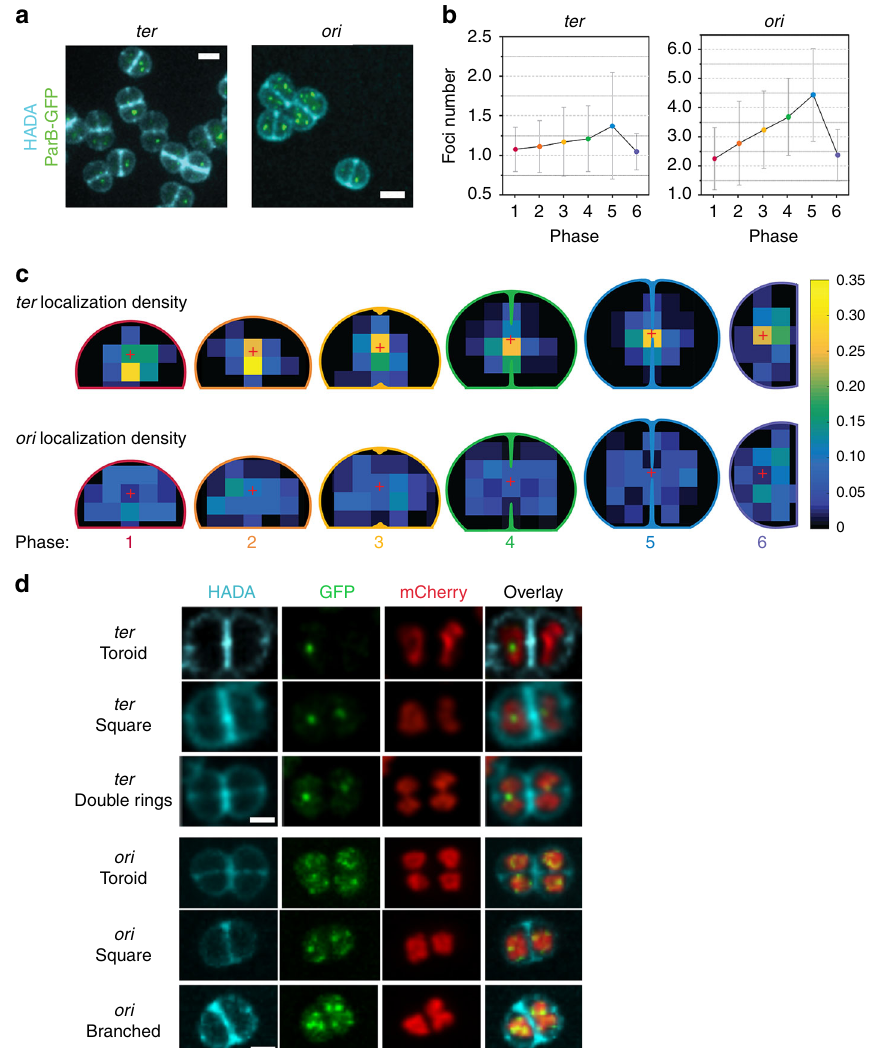
Fig. 6 Distribution and choreography of ter and oriC loci of chromosome 1. a Images of D. radiodurans strains GY15787 and GY15800 expressing HU- mCherry and a heterologous ParB fused to GFP (green foci), with multiple copies of its cognate parS sequence inserted nearby chromosome 1 ter (left) or oriC (right) loci, respectively (Table 1), and stained with the cell wall HADA dye (blue). For clarity, the HU-mCherry signal is not included in these images. Scale bar: 2 µ m. b Number of ter and oriC foci detected per cell at the different phases of the cell cycle retrieved from 3D images. Data are represented as mean ± SD. c Weighted distribution density of ter (top) and oriC (bottom) foci at the different phases of the cell cycle. The red cross indicates the centre of the cell. b , c ter ( N = 315; N > 37 for each phase) or oriC ( N = 368; N > 36 for each phase) foci were analysed and data were retrieved from two independent experiments. d Examples of ter and oriC foci localization relative to the different nucleoid conformations of D. radiodurans , expressing HU-mCherry (red) and ParB-GFP (green), and stained with the cell wall dye HADA (blue). Scale bar: 1 µ m. Source data are provided as a Source Data fi